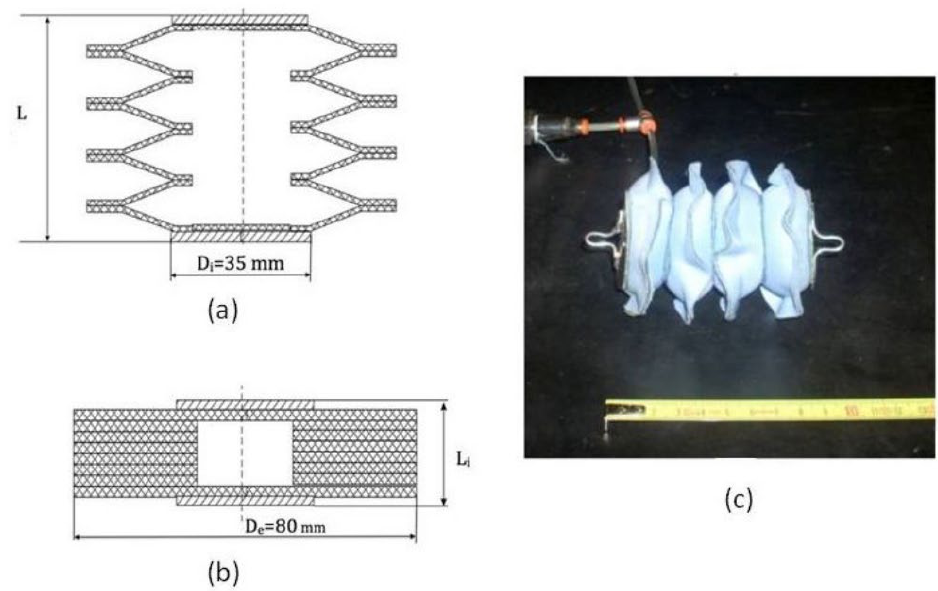
Figure 10. Textile bellow muscle prototype: ( a , b ) sketches of actuator’s section; ( c ) picture of the actuator in pressurized condition [31,60].